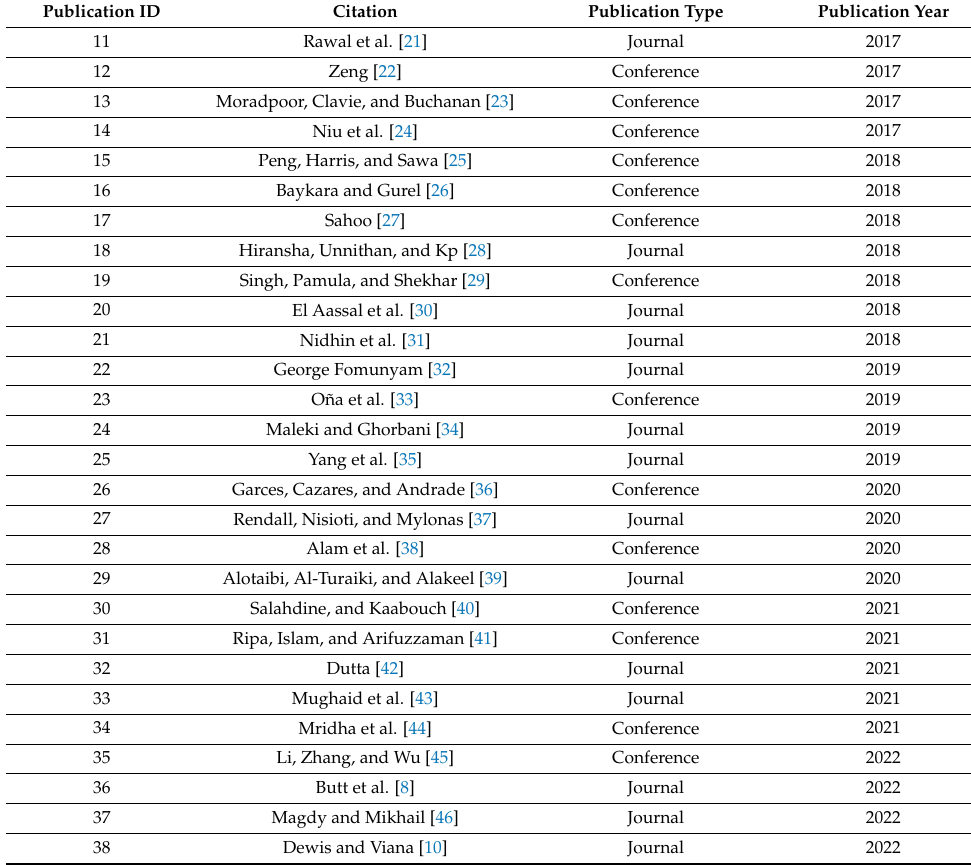
Table 3. Summary of recent studies in the literature regarding BEC phishing attacks.